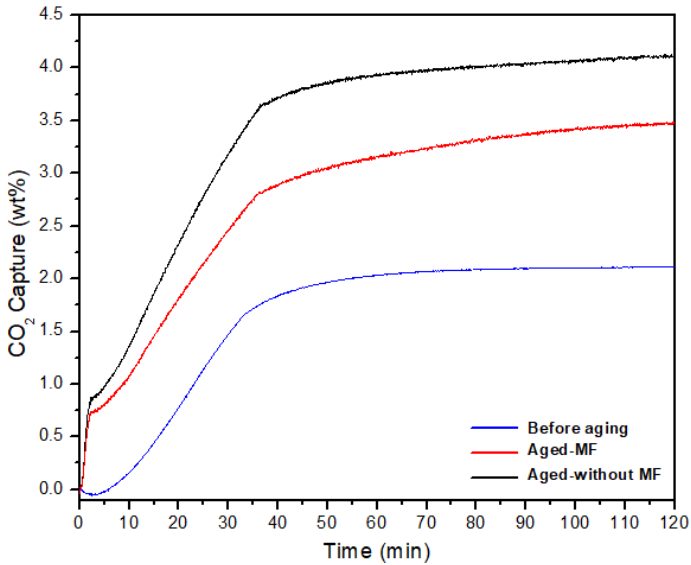
Figure 1. TGA data for electrospun MgO-based nanocomposites before aging, aged under MF, and aged without MF at room temperature.